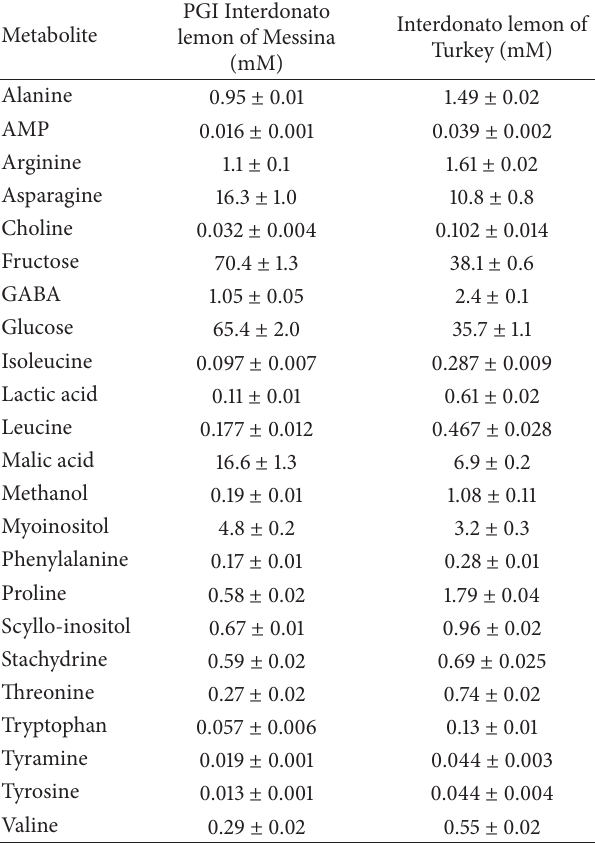
Table 2: Average metabolites molar concentration of PGI Interdo- nato lemon of Messina and Interdonato lemon of Turkey juices.